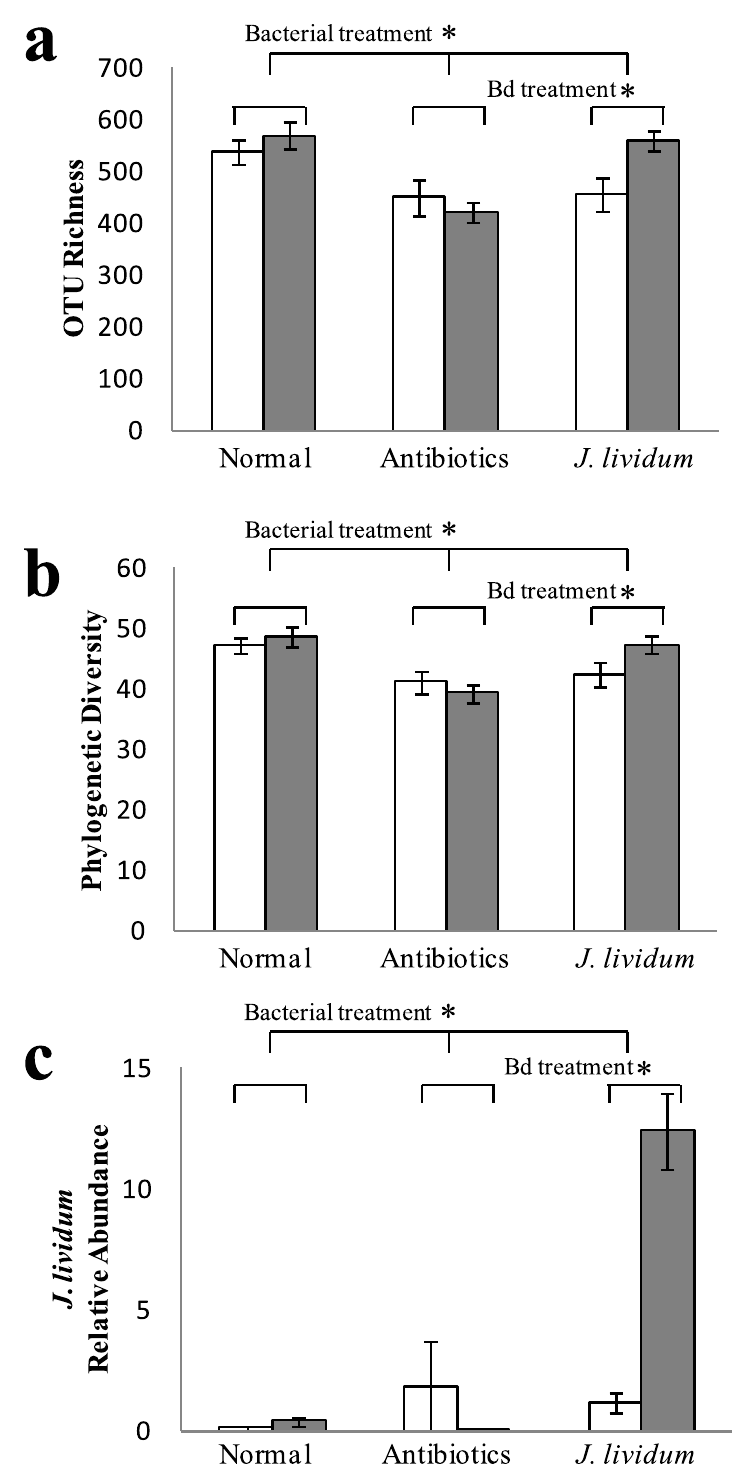
Fig 4. Effects of Bd exposure (white bars = No exposure to Bd; grey bars = Exposure to Bd) and bacterial treatment (normal, antibiotics, and augmented with J . lividum ) on OTU richness (a), phylogenetic diversity (b), and relative abundance of the probiotic J . lividum (c) on bullfrog skin one week following exposure to Bd (day 7). Error bars represent standard error. * represent significant differences among